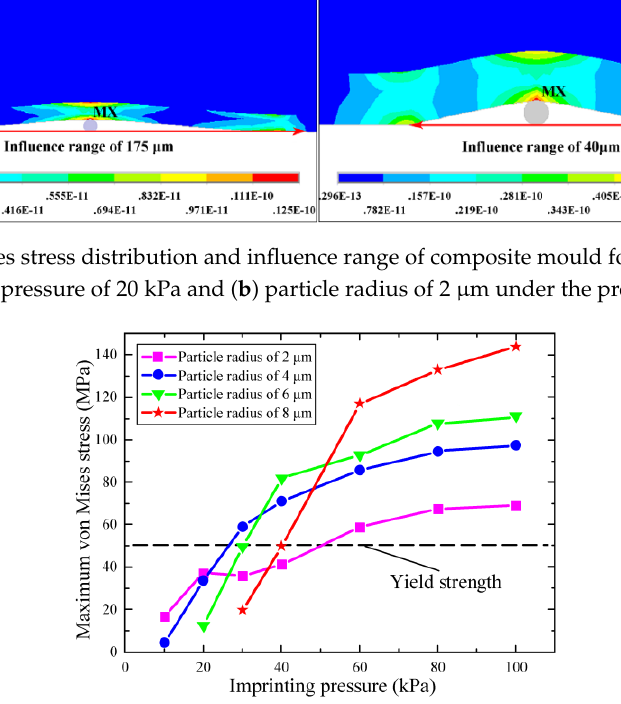
Figure 4. The maximum von Mises stress of composite mould for various pressures on the particles radius from 2 to 8 μm.